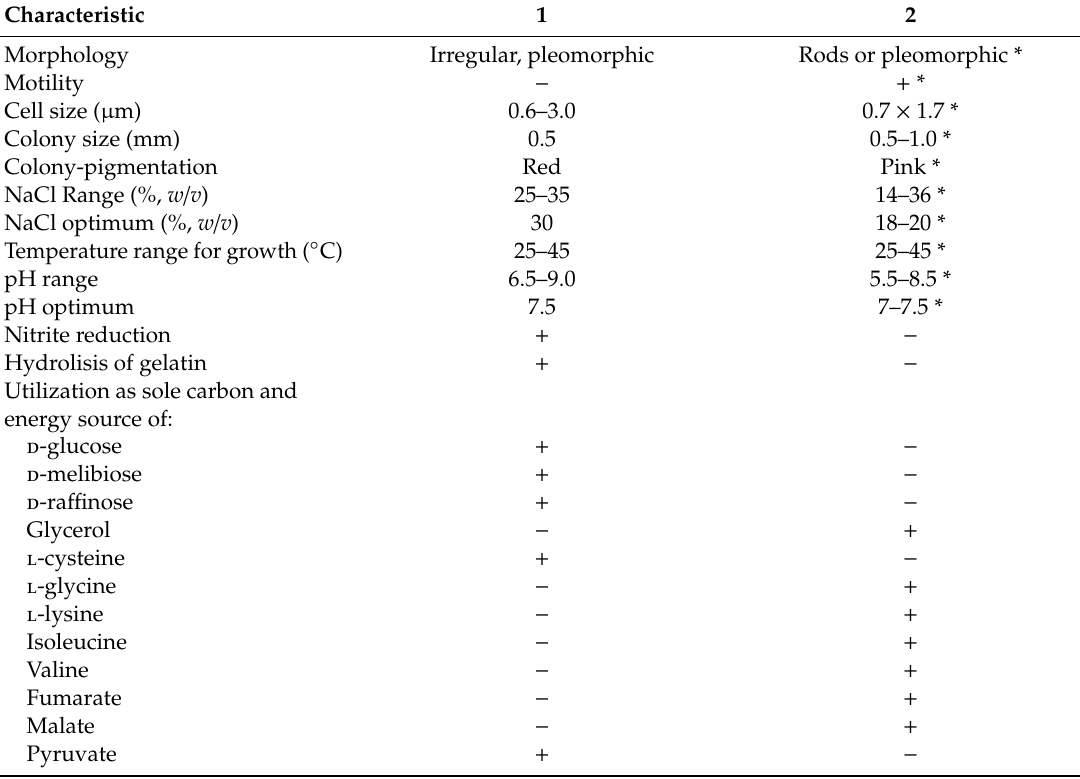
Table 2. Di ff erential characteristics of strain F16-60 T and Natronomonas moolapensis CECT 7526 T .